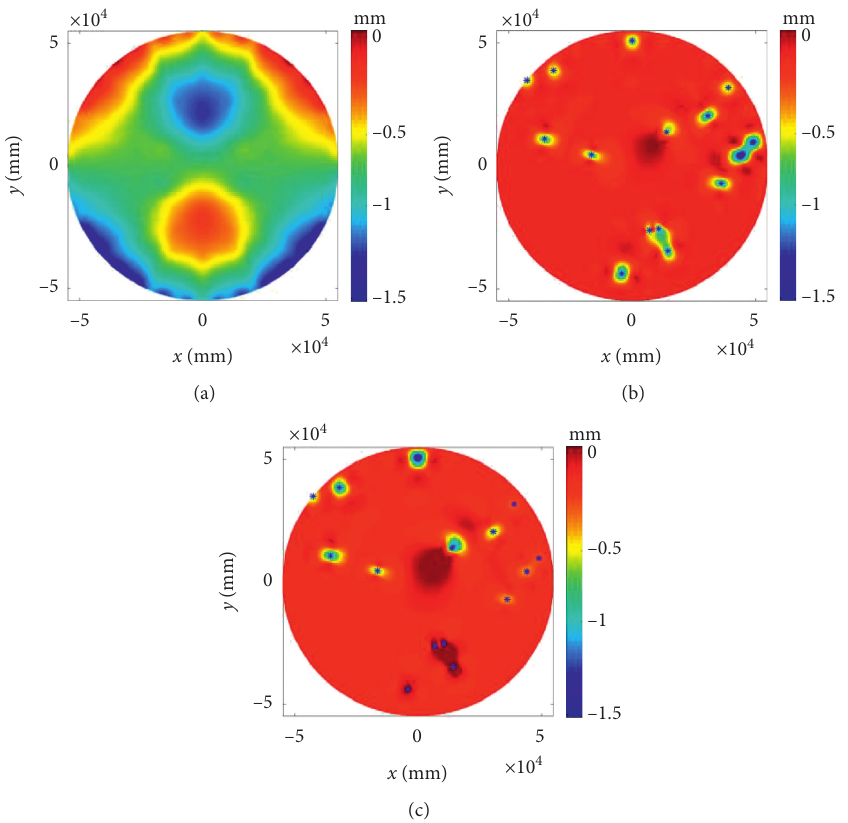
Figure 6: Compare with the main reflector rms deformation at 0deg elevation. (a) The reflector deformation before actuator failure. (b) The reflector deformation after actuator failure. (c) The reflector deformation at tolerance method.